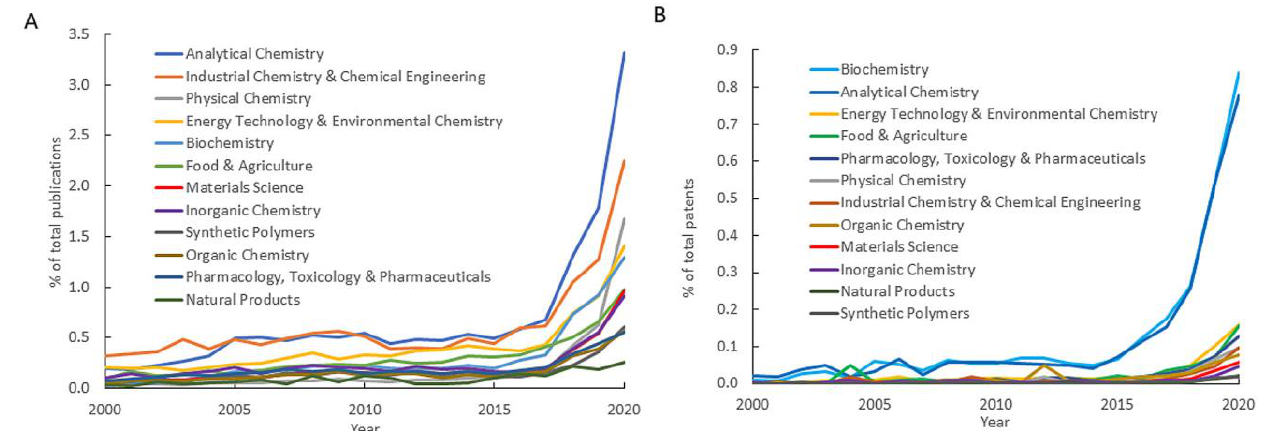
Figure 1. Publication trends for AI in different research areas from 2000 to 2020: ( A ) journal publications and ( B ) patent publications. Reproduced with permission from [Baum, Z.J.; Yu, X.; Ayala, P.Y.; Zhao, Y.; et al], [Artificial Intelligence in Chemistry: Current Trends and Future Directions]; published by [J. Chem. Inf. Model], [2021].